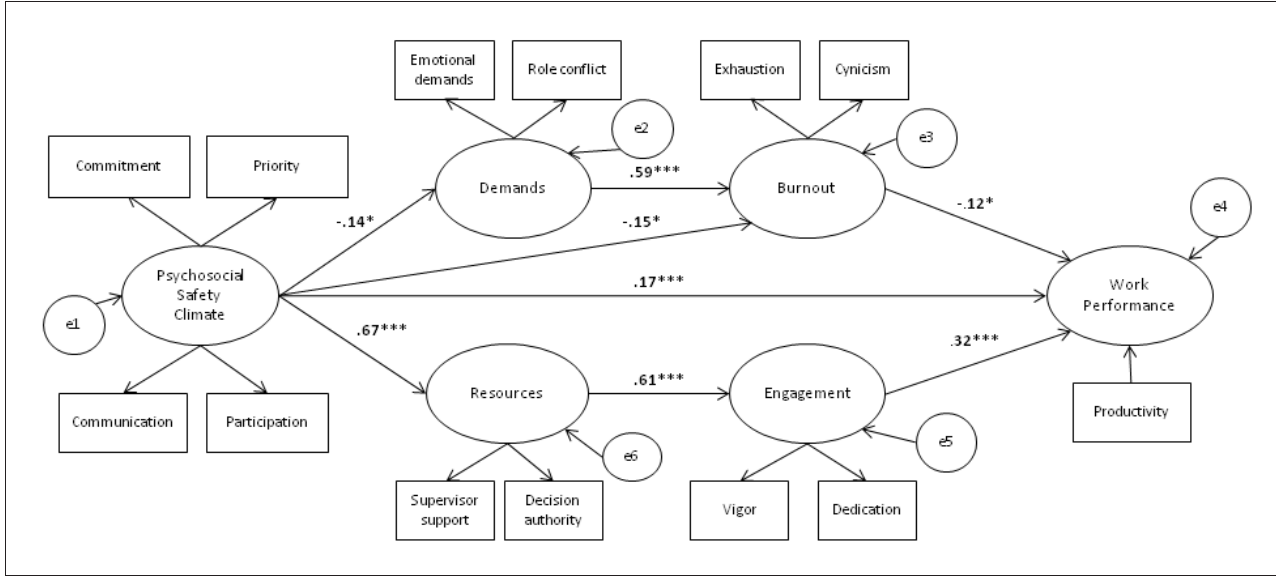
FIGURE 2 : PSC as a precursor to job demands and resources, and its impact on preformance through burnout and